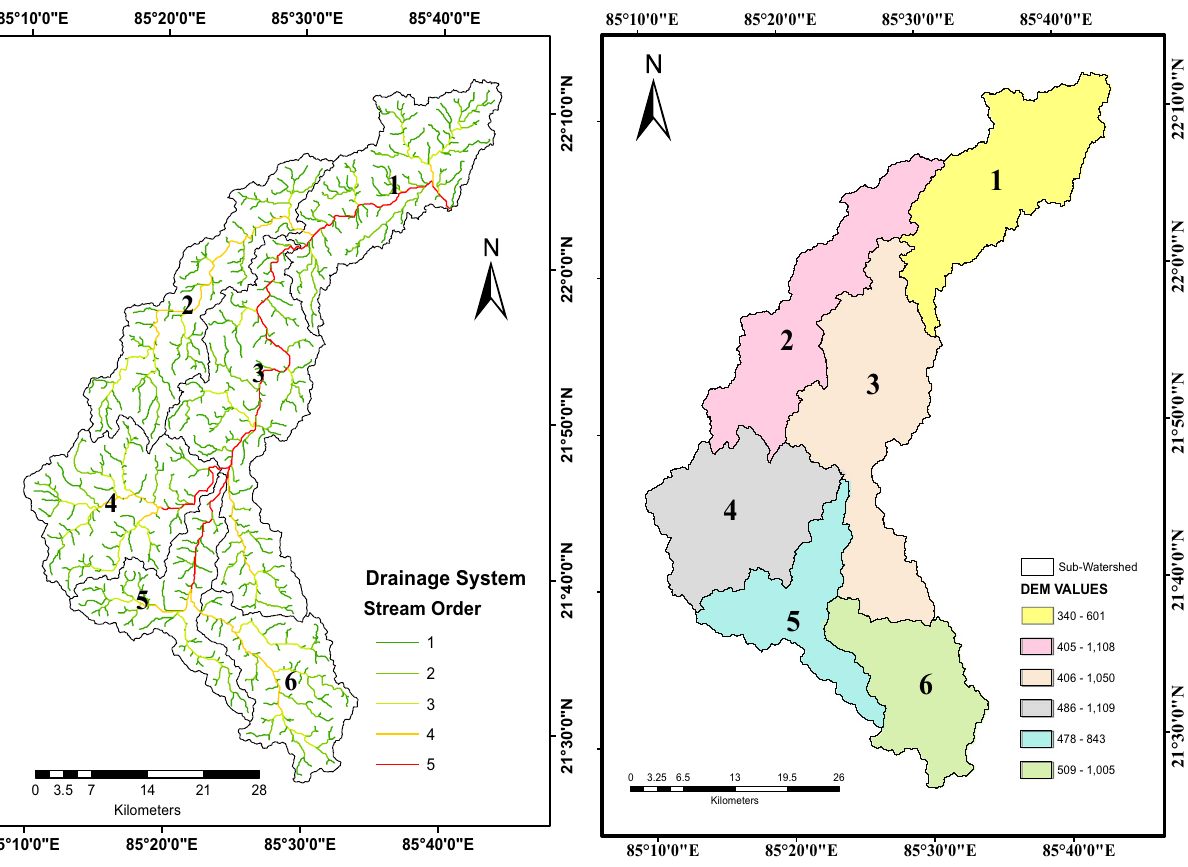
Fig. 3 Watershed characteristics. a Stream order of sub-watersheds. b Digital elevation map of the